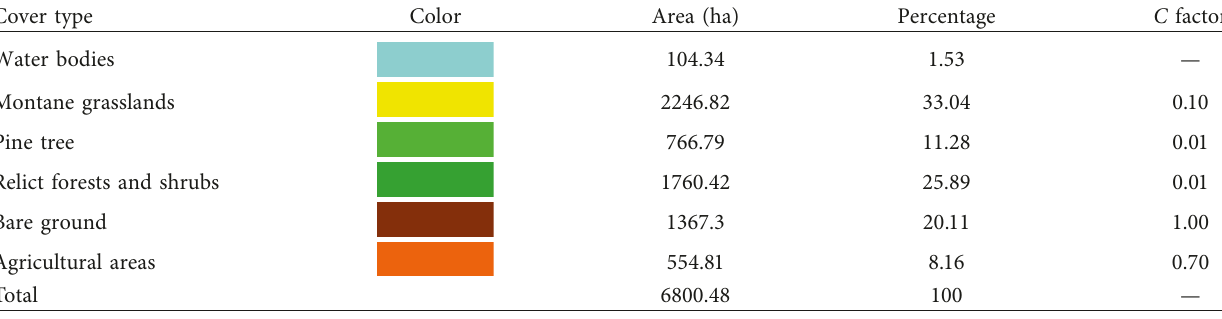
Table 1: Soil coverage ( C factor) for ACP